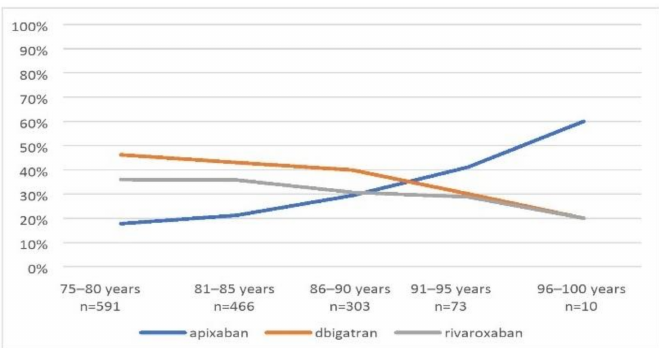
Figure 2. Division into individual NOACs depending on the age.